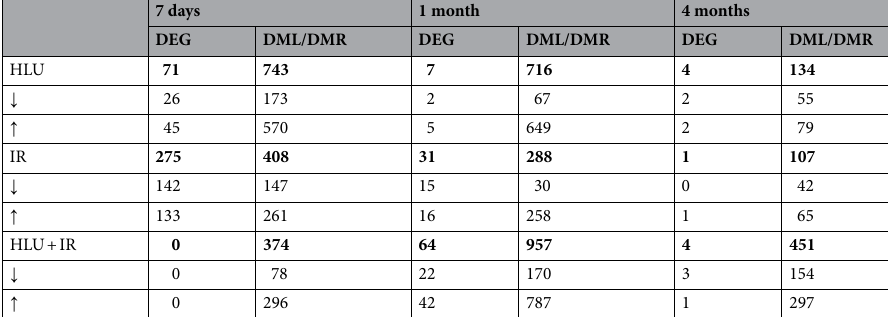
Table 1. Number of differentially expressed genes and differentially methylated genes across exposure groups. DEG (|log 2 (fold-change)|≥ 0.263 and adjusted p -value ≤ 0.05) and DMG (genes containing CpG loci or regions with |percent methylation difference|≥ 10 and adjusted p -value ≤ 0.05) are listed in bold for each experimental group compared to its matched control. DEG counts are separated by down ( ↓ ) or up ( ↑ ) regulation; DML/ DMR counts are separated by hypo ( ↓ ) or hyper ( ↑ ) methylation. DEG differentially expressed genes,